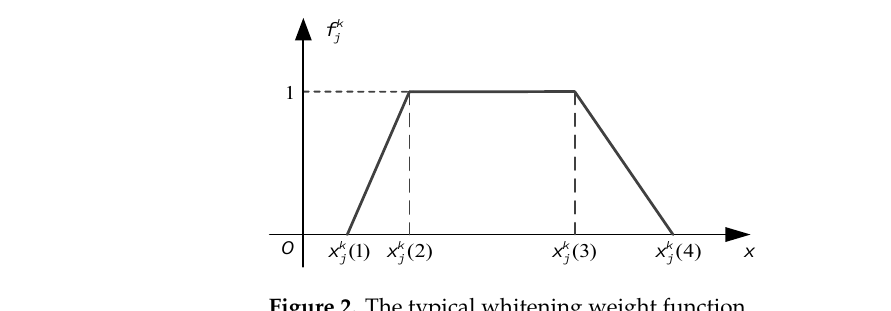
Figure 2. The typical whitening weight function.